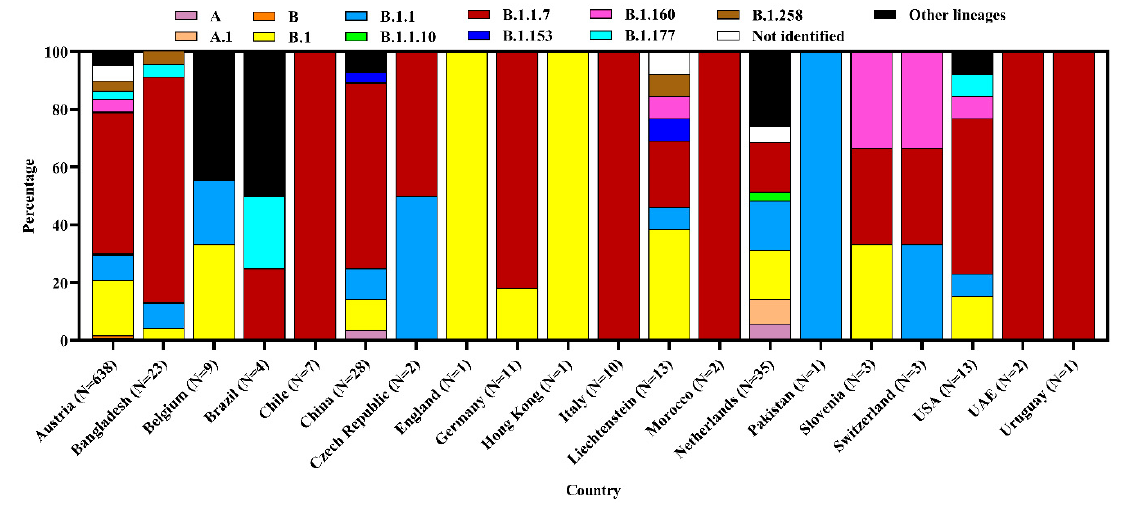
Figure 6. Lineage diversity of SARS-CoV-2 strains from environmental samples.